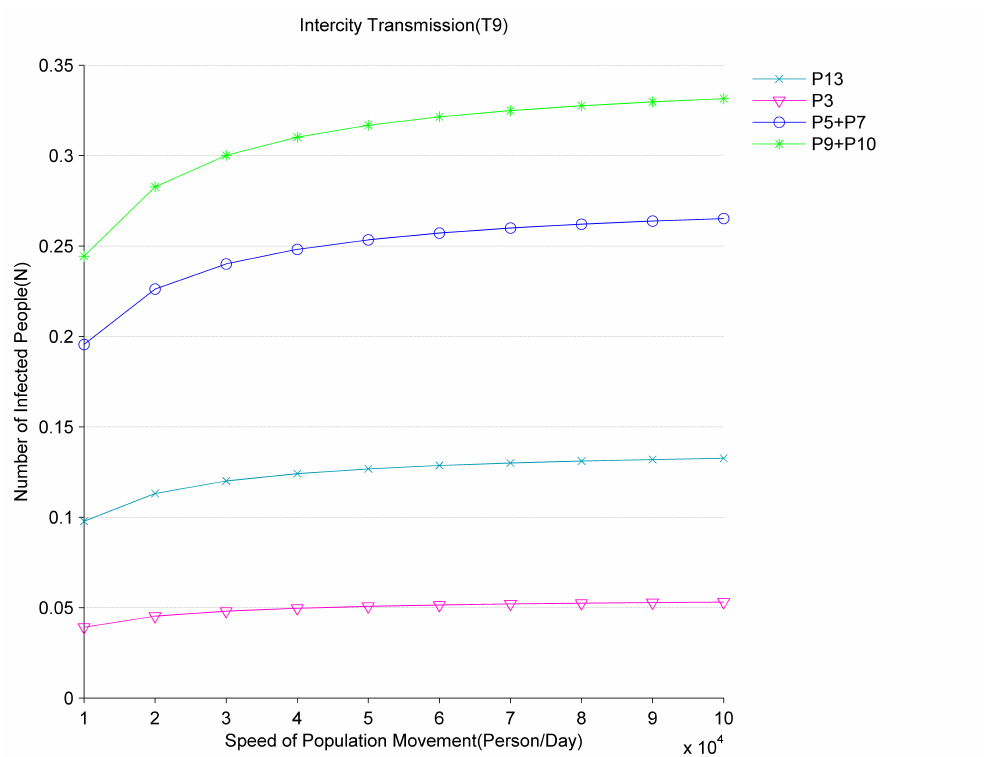
Figure 8. Impact of the speed population movement on the virus